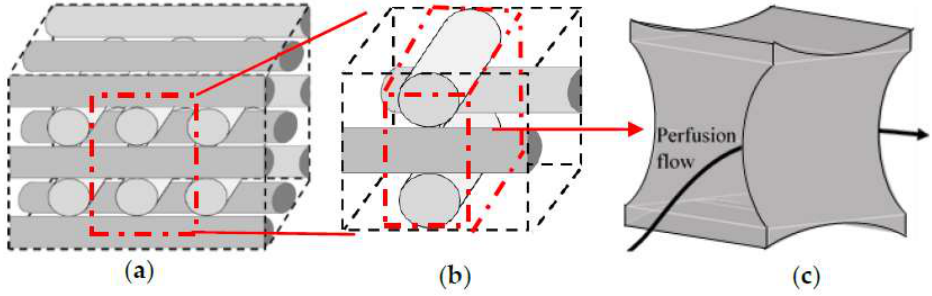
Figure 3. Geometry simplification ( a ) full structure, ( b ) conjunction of four fibers, ( c ) the studied simulation volume (unit).